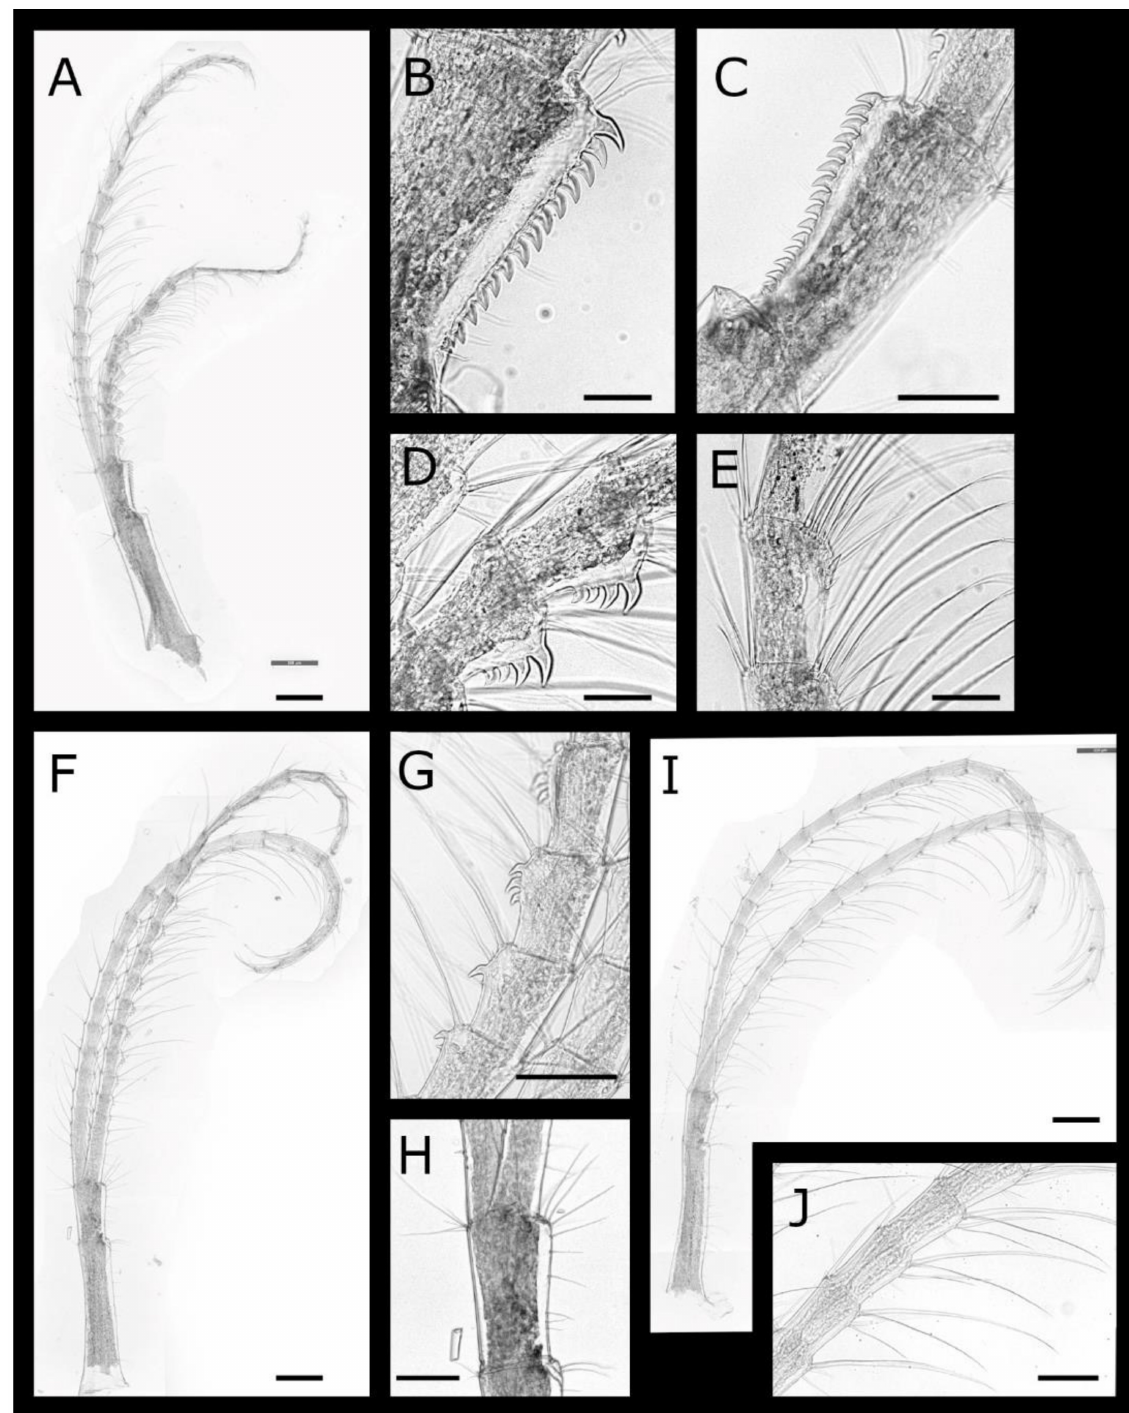
Figure 24. Pectinoacasta pectinipes (Pilsbry, 1916) cirri IV–VI (WAM C58871). ( A ) left cirrus IV; ( B , C ) left and right cirrus IV protopod basis; ( D ) hooked teeth on medial segments of left cirrus IV anterior ramus; ( E ) setation on distal segments of left cirrus IV anterior ramus; ( F ) left cirrus V; ( G ) hooked teeth on medial segments of right cirrus V anterior ramus; ( H ) protopod of left cirrus V; ( I ) left cirrus VI; ( J ) medial segments of left cirrus VI. Scale bars: A, F, I = 200 µ m; B, D, E = 50 µ m; C, G,H, J = 100 µ